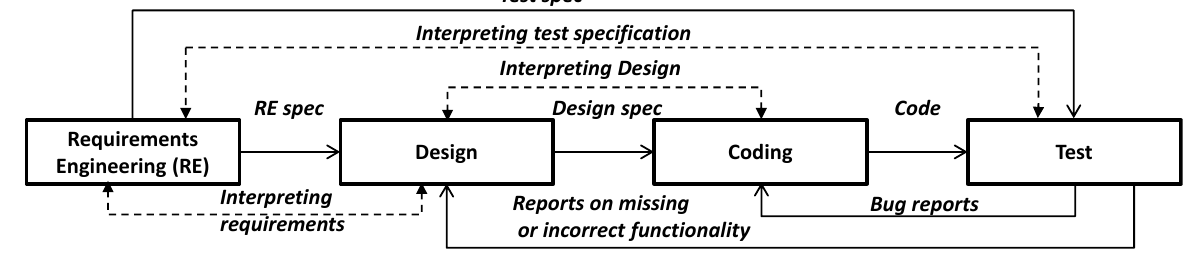
Figure 4. Diagram from Figure 1 complemented with feedback